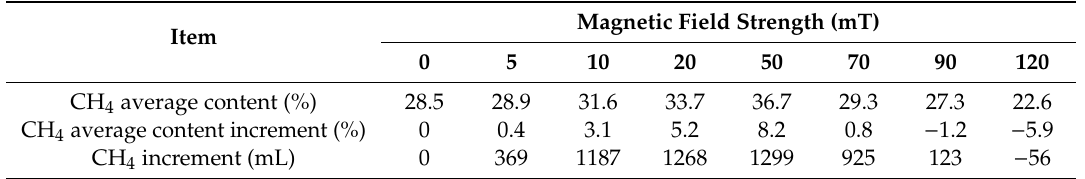
Table 4. Total biogas production and methane production at di ff erent magnetic field